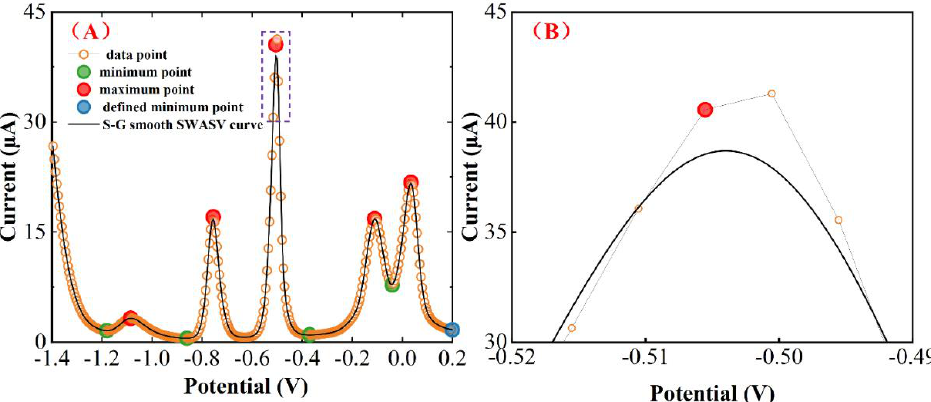
Figure 11. Schematic representation of the local maximum points calculated by homemade algorithm ( A ), and the deviator between the local extreme points of the curve in the dotted box and the extreme point (red point) obtained by the homemade algorithm ( B ).